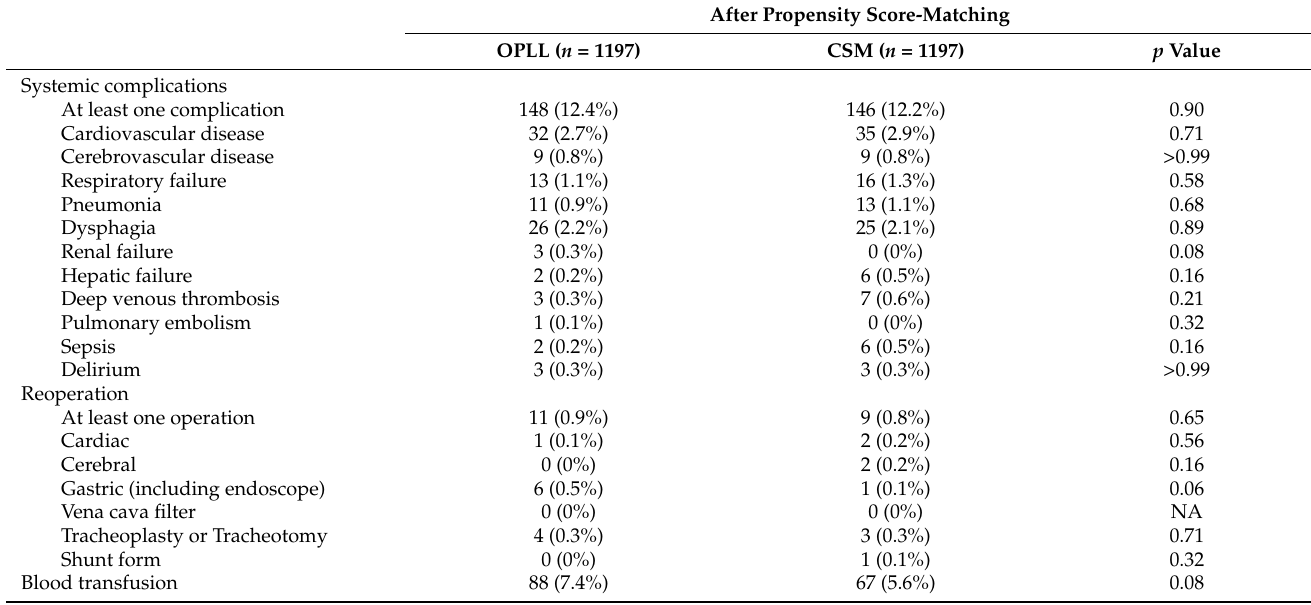
Table 2. Systemic complications, reoperation, and blood transfusion after